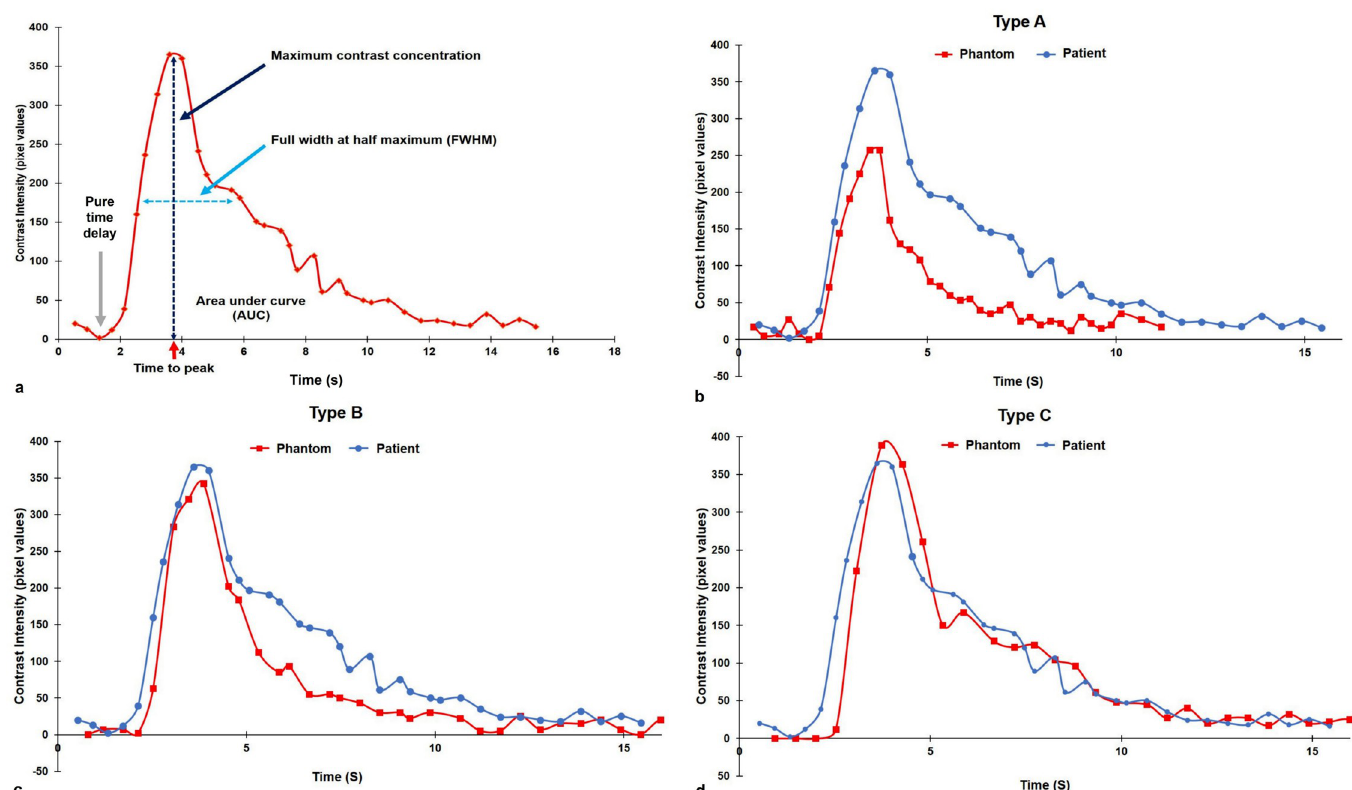
Fig 5. Graph descriptions of contrast concentration-time curves (CCTCs) (a) and comparisons between the original control group (blue lines), and three types of cerebrovascular phantoms (red lines) (b–d). (a) The CCTC comprises four parameters (maximum contrast concentration, time-to-peak, full-width-at-half-maximum [FWHM], and area under curve [AUC]). The time-to-peak represents the time at the maximum contrast concentration of the selected ROI. The FWHM and AUC were measured to compare the widths of curves. (b) Pairwise comparisons between the original control group data and (b) the CASP phantom (type A), (c) phantom with plastic cistern only (type C), and (d) plastic cistern with a sponge pad (type